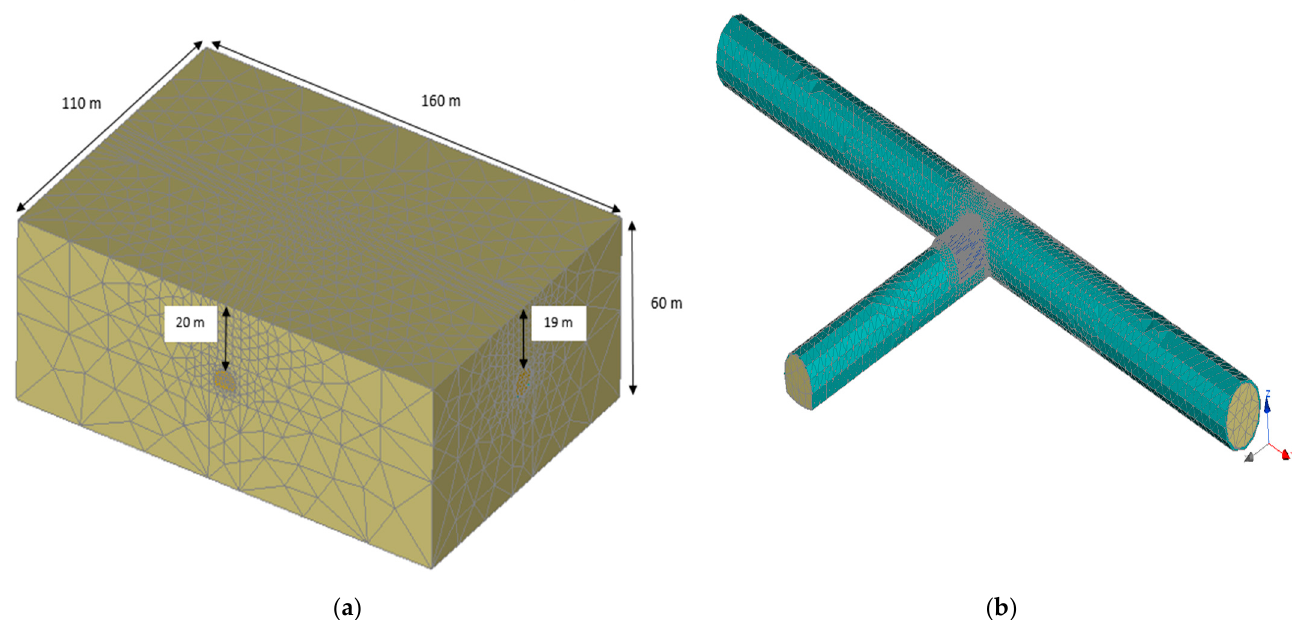
Figure 2. Location of the cross passage 6 in the Algiers metro project, Algeria.